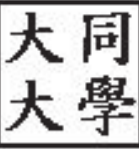
Figure 10: The authentication logo (64 × 64).